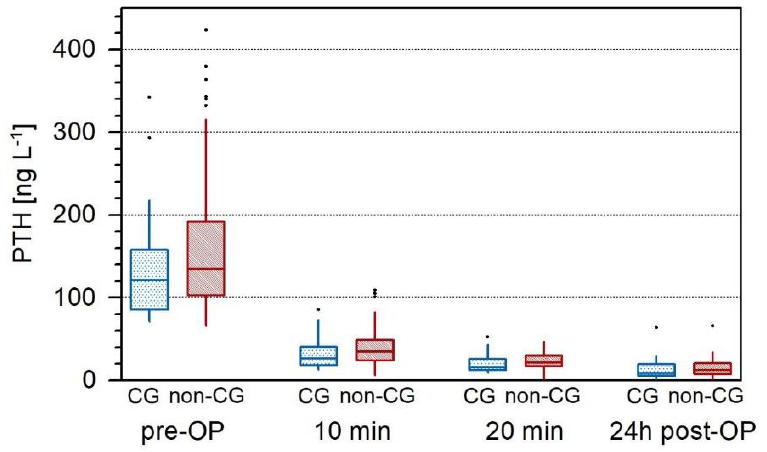
Figure 2. Box plot illustrating the time trends for PTH (ng/L). Time is significant ( p < 0.001) as PTH drop was significant for both groups at any time point. Cinacalcet effect is not significant and not clinically relevant.